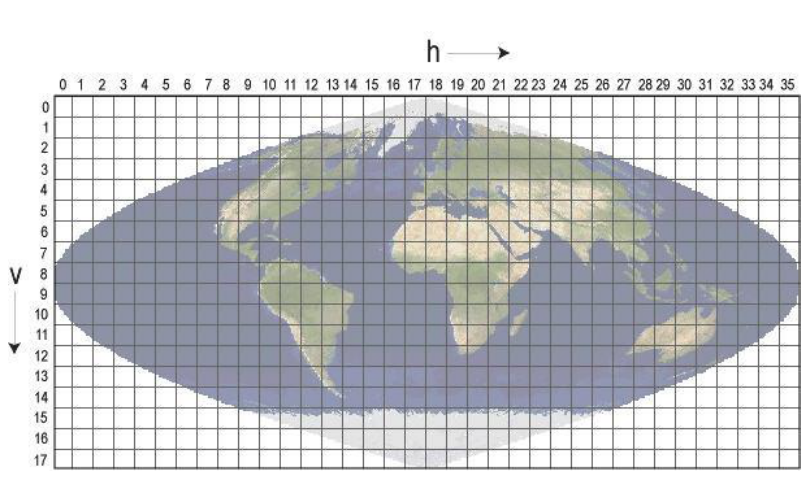
Figure 1. MODIS sinusoidal tiling system [31].